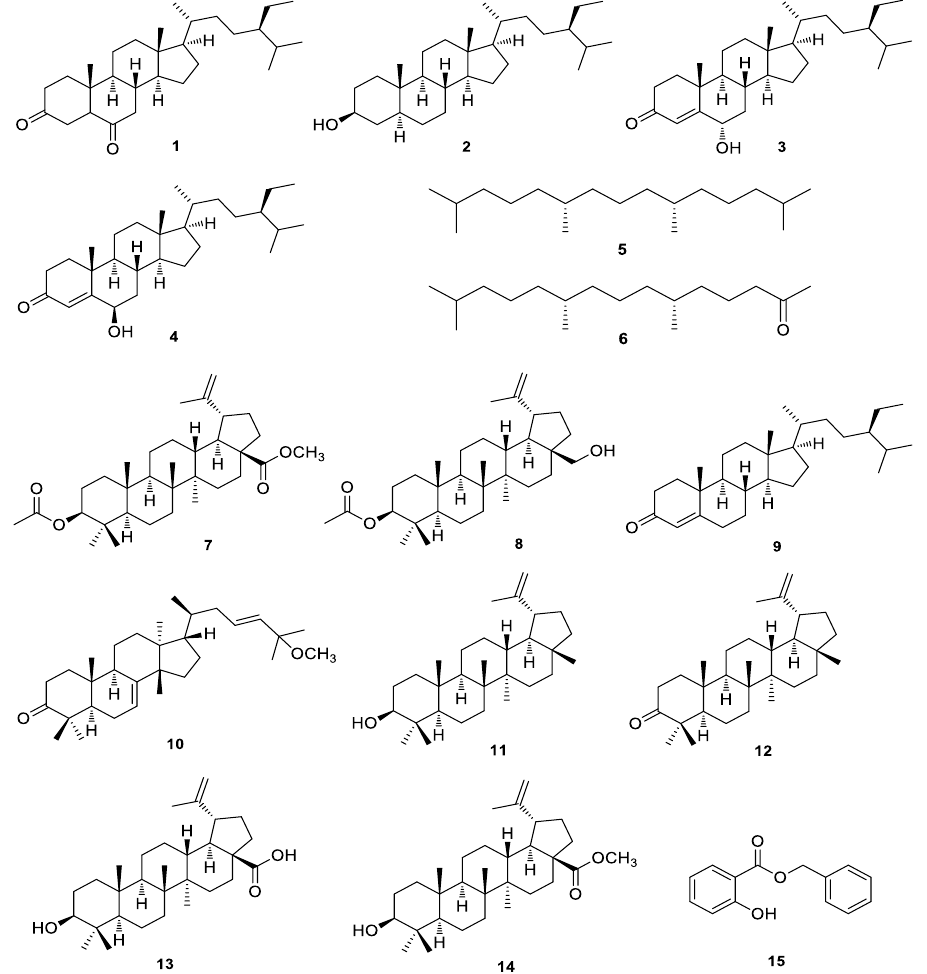
Figure 2. Chemical structures of compounds 1 – 15 . 5α-Stigmast-3,6-dione ( 1 ), 3β-sitostanol ( 2 ), 6α-hydroxy-β-sitostenone ( 3 ), 6β-hydroxysitostenone ( 4 ), norphytan ( 5 ), phytone ( 6 ), methyl 3- O -acetylbetulinate ( 7 ), 3- O -acetylbetulin ( 8 ), sitostenone ( 9 ), leucophyllone ( 10 ), lupeol ( 11 ), lupenone ( 12 ), betulinic acid ( 13 ), betulinic acid methyl ester ( 14 ), and benzyl salicylate ( 15 ).